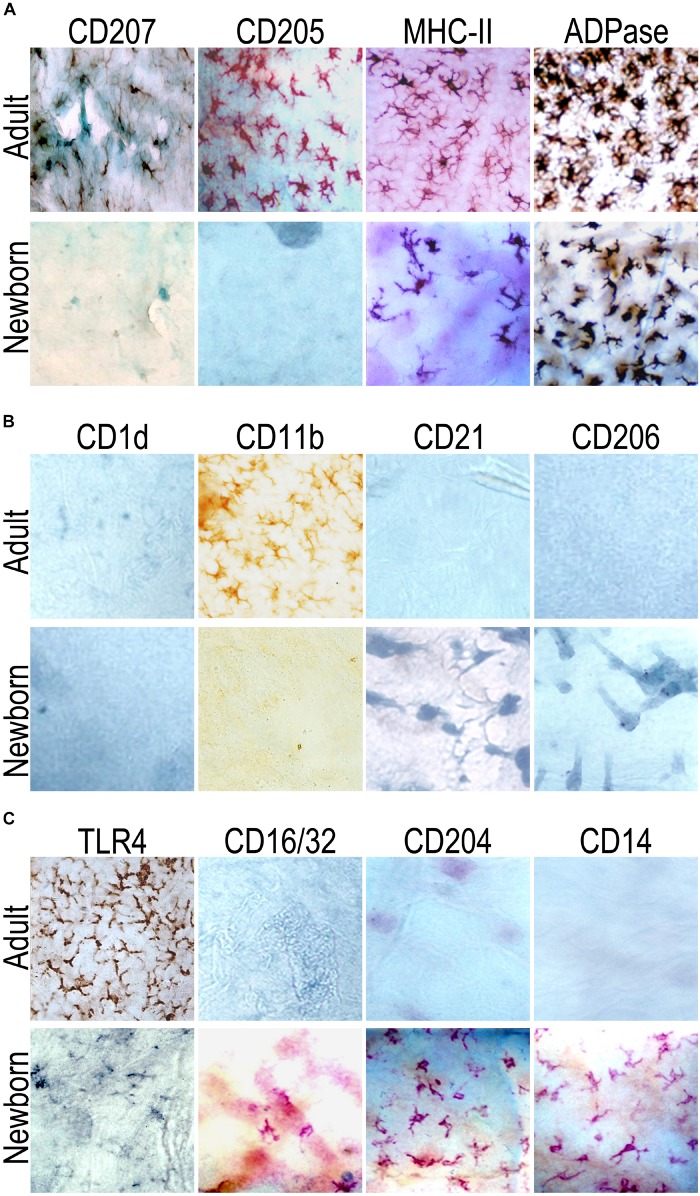
Langerhans cells (LC) in neonates can be identified by means of ADPase staining and express different molecules than in adults. Epidermal sheets from adult (top panel) or newborn (at birth, day 0, bottom panel) mice were probed for the expression of (A) CD207 (Langerin), CD205, MHC-II or ADPase activity. Neonatal epidermal LCs were positive for the ADPase activity and very few cells (in small clusters) expressed MHCII. (B) CD1d, CD11b, CD21, CD206; and (C) TLR4, CD16/32, CD204, and CD14. While neonatal epidermal LCs at birth were CD204+ and CD14+, epidermal LCs from adults did not express these molecules. Although the frequency of TLR4+ epidermal LCs in neonates was very scant, the TLR4+ cells in adults were widely distributed through the whole epidermis. Representative pictures are shown from at least nine mice evaluated in three independent experiments.